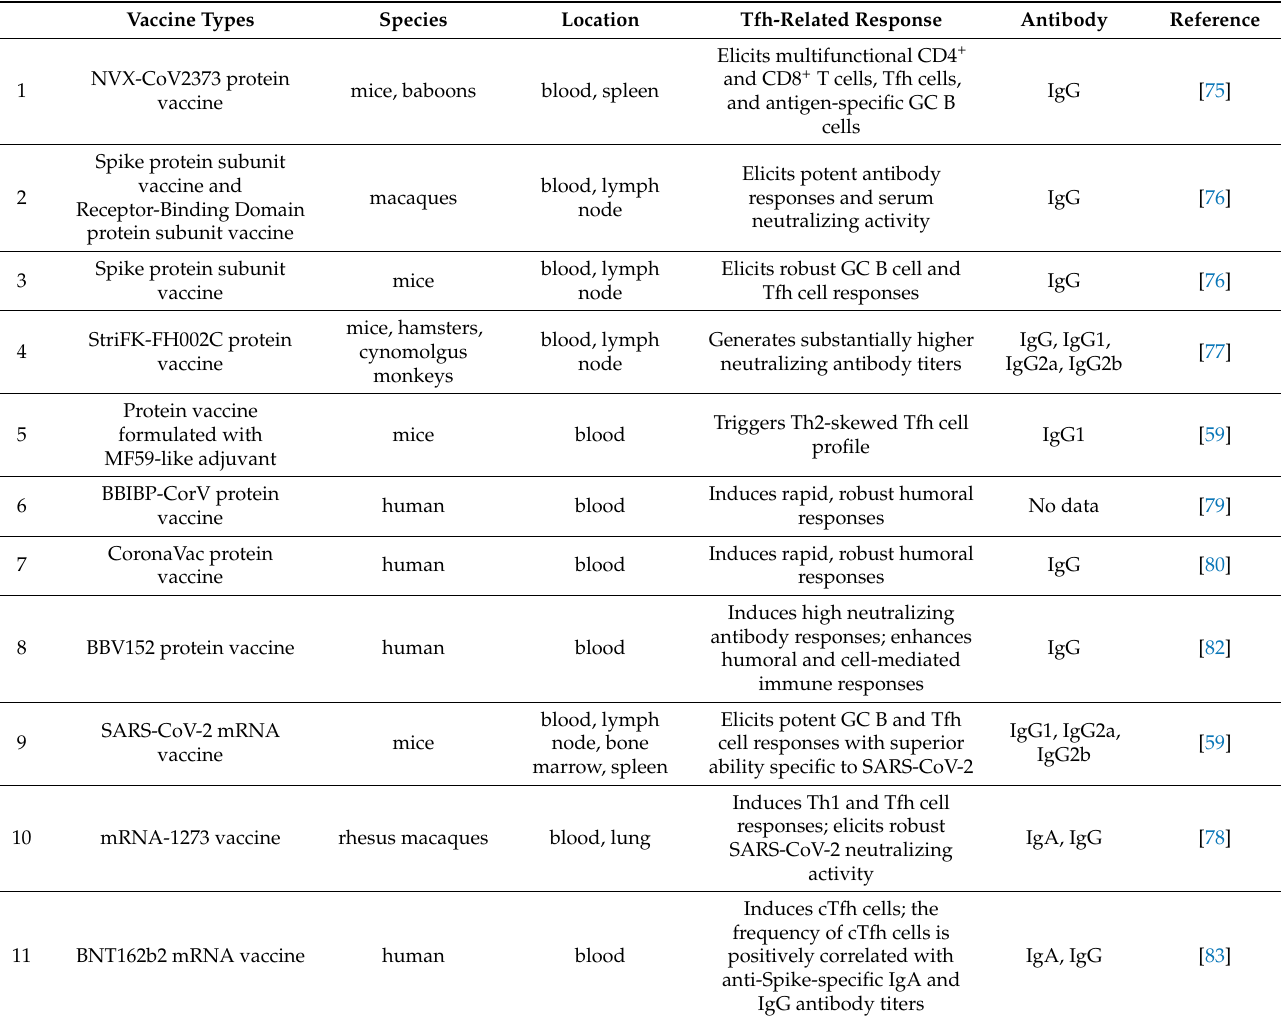
Table 1. Tfh cell responses to various types of SARS-CoV-2